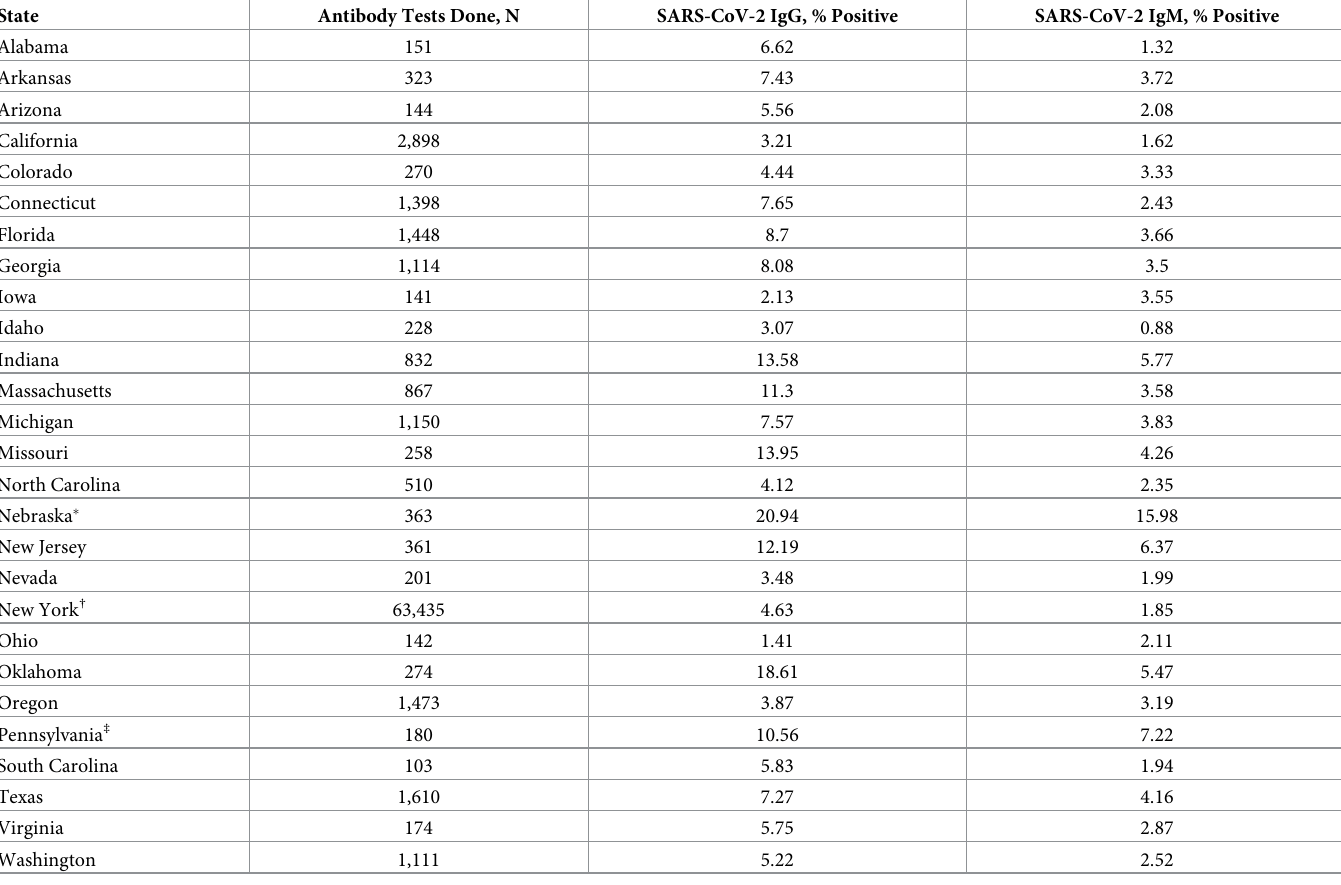
Table 4. SARS-CoV-2 antibody testing by states with > 100